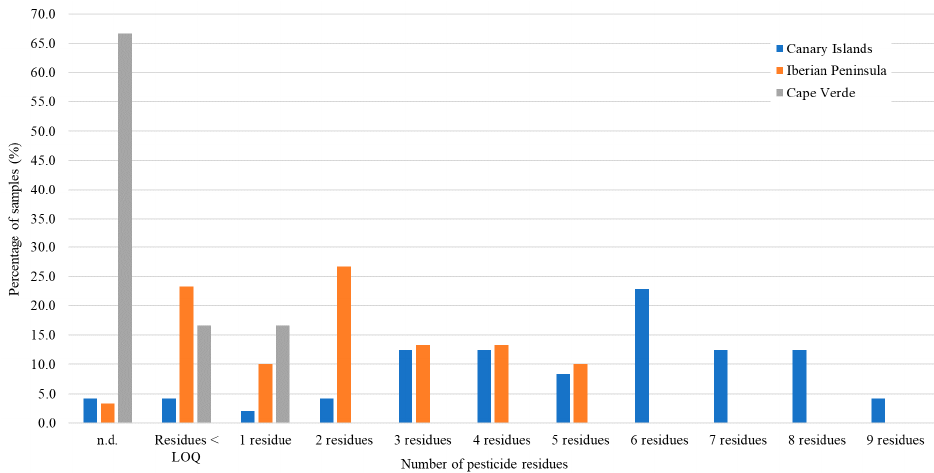
Figure 1. Histogram of the distribution of red wine samples according to the number of pesticide residues detected, differentiating between the Canary Islands ( n = 48), the Iberian Peninsula ( n = 30), and Cape Verde ( n = 6) regions.